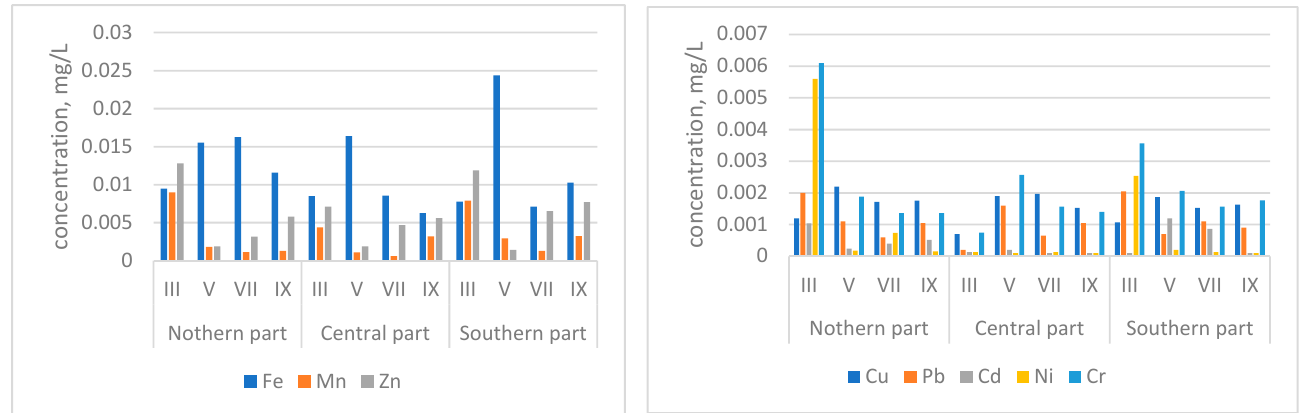
Figure 7. The seasonal variability of metals content in surface water of Lake Gusinoe. Metal concentration, mg/L.